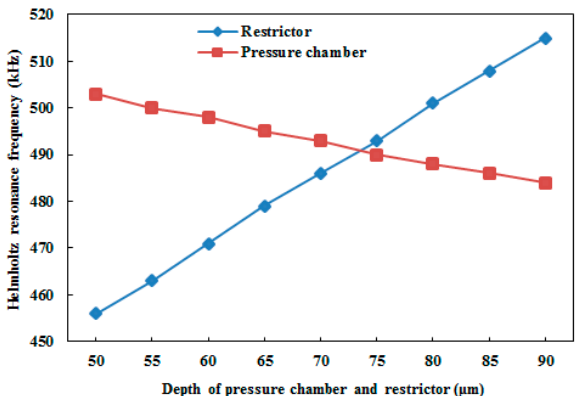
Figure 10. Comparative analysis of the effect of the depth variation of the pressure chamber and the restrictor on the Helmholtz resonance frequency.